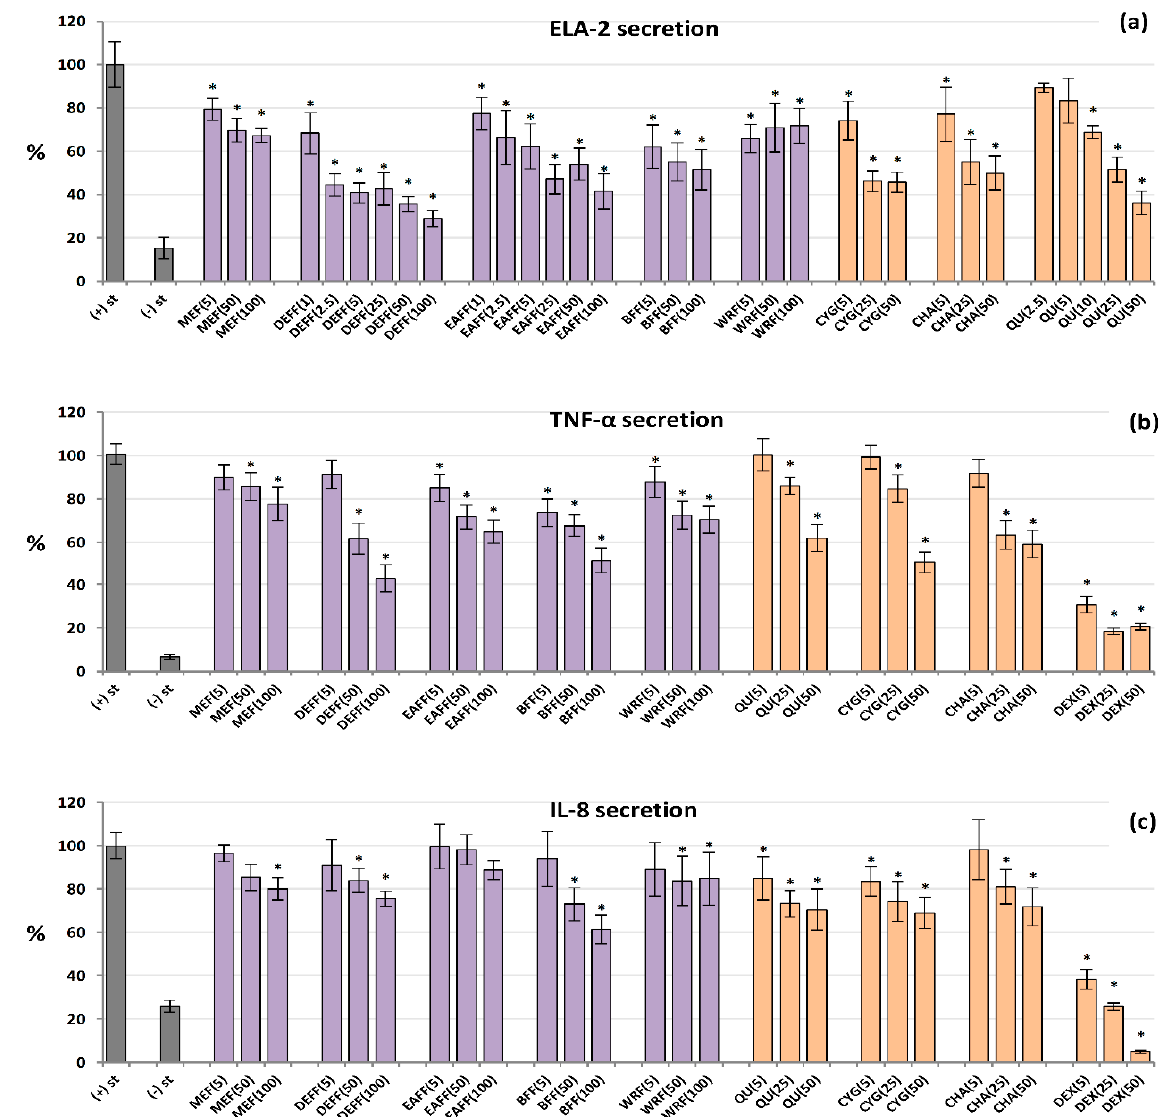
Figure 4. Effect of fruit extracts/fractions (1–100 µg/mL) and standards (5–50 µM) on pro-inflammatory functions of stimulated human neutrophils: effects on the release of ( a ) ELA-2, neutrophils elastase; ( b ) TNF- α , tumour necrosis factor α ; and ( c ) IL-8, interleukin 8. Positive controls: QU, quercetin; DEX, dexamethasone. For extracts codes see Table 1. Data expressed as means ± SD of five independent experiments performed with cells isolated from five independent donors. Statistical significance in Dunnett’s test: * p < 0.05 compared with the stimulated